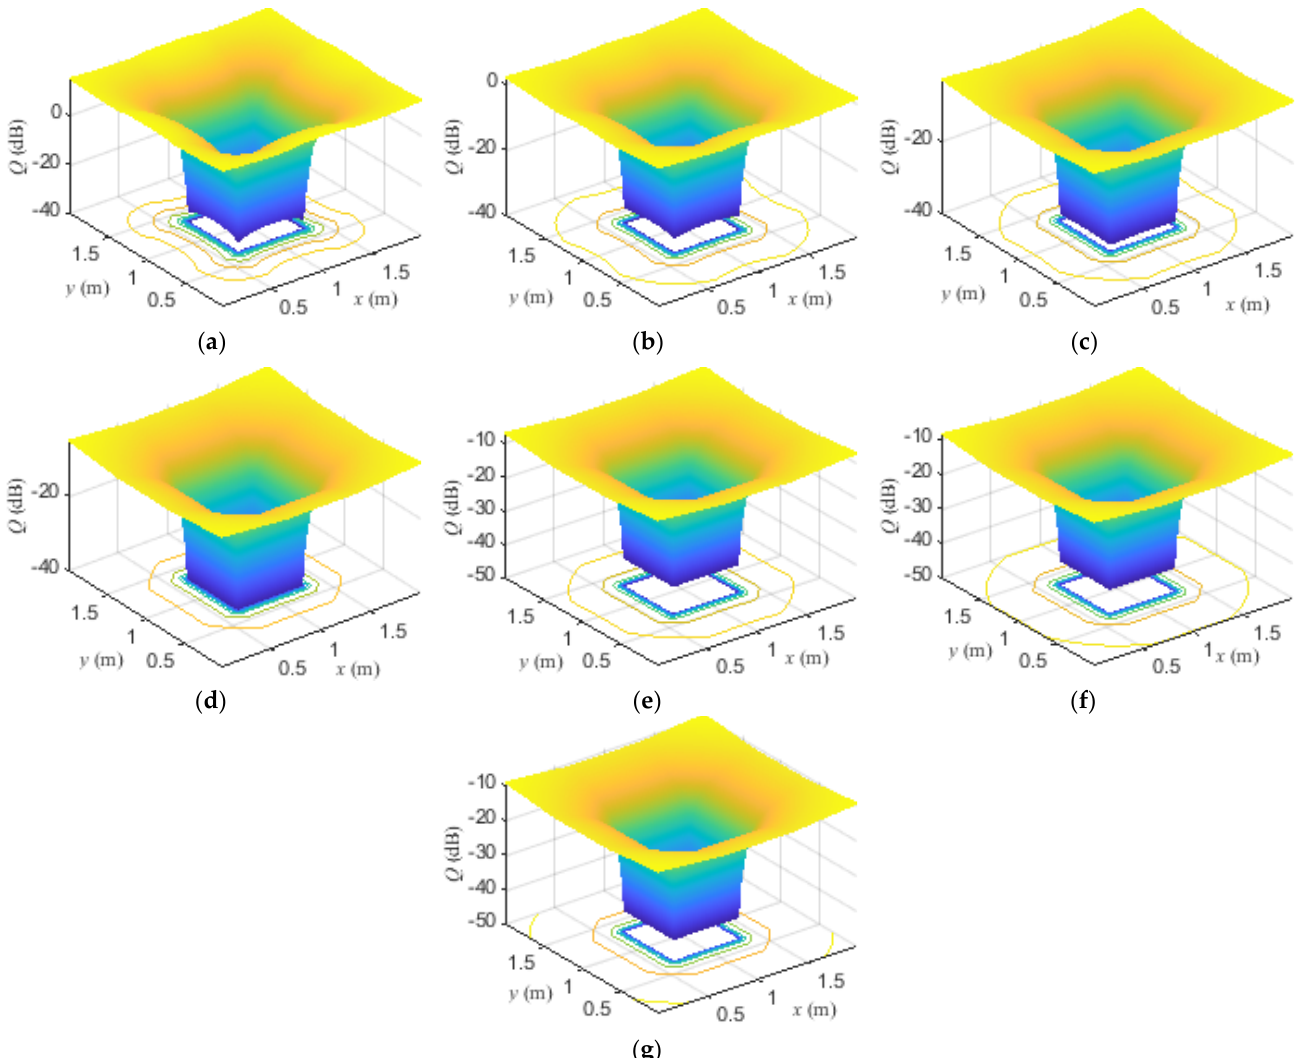
Figure 12. Calculation results of the relationship between the Q and LED position at a room size of 2 m × 2 m: ( a ) θ 1/2 = 10°; ( b ) θ 1/2 = 20°; ( c ) θ 1/2 = 30°; ( d ) θ 1/2 = 40°; ( e ) θ 1/2 = 50°; ( f ) θ 1/2 = 60°; ( g ) θ 1/2 = 70°.